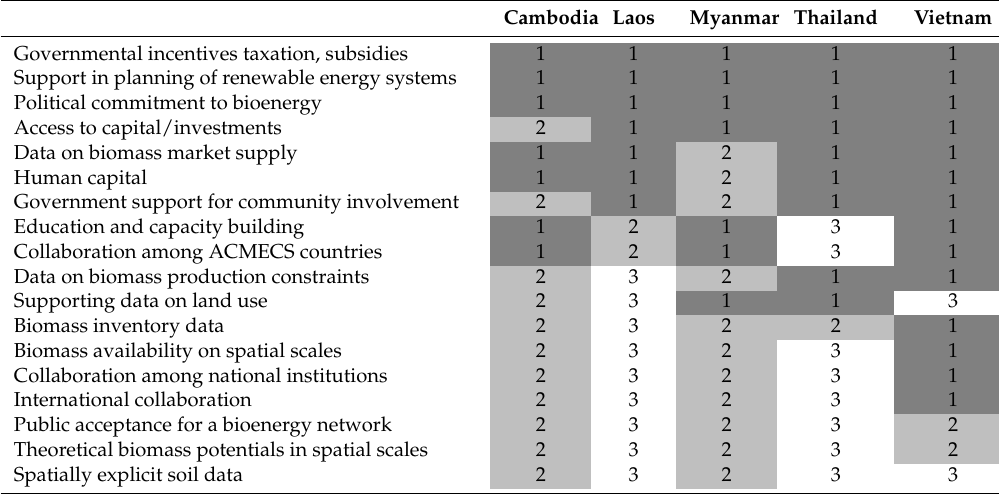
Table 5. Requested preconditions for a successful network implementation as expressed by respondents, expressed by the ranked median values. 1 = highly needed, 2 = needed, 3 = not essential. Background colors represent classes